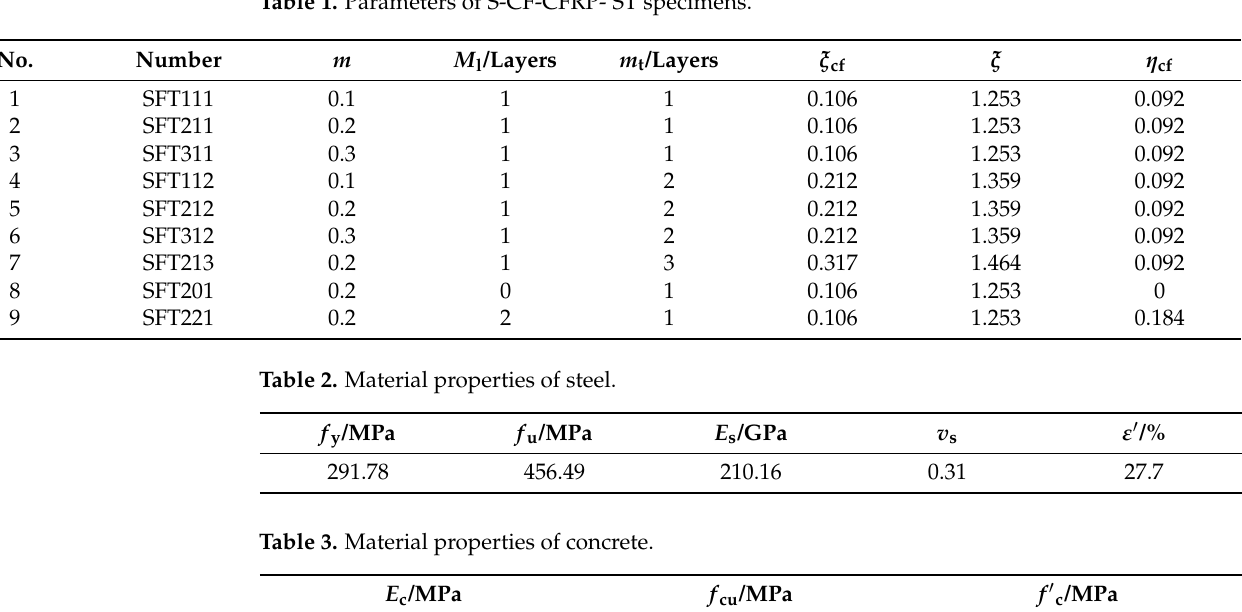
Table 1. Parameters of S-CF-CFRP- ST specimens.